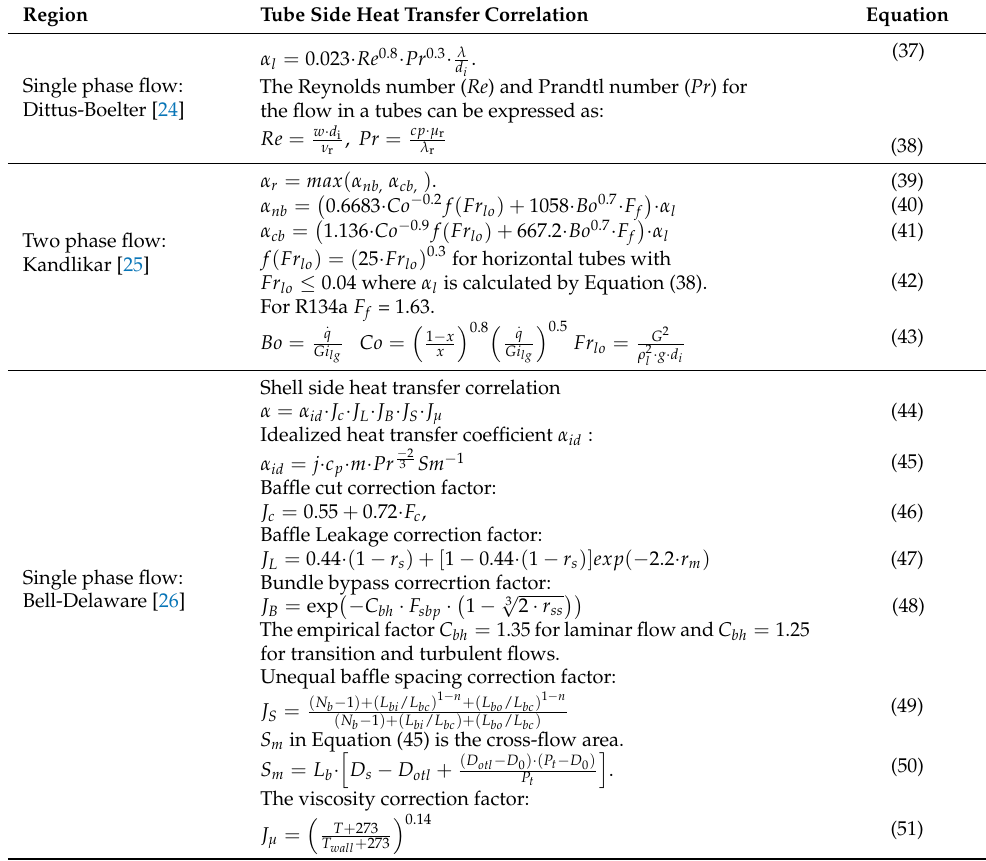
Table 1. Correlations for heat transfer coefficient.